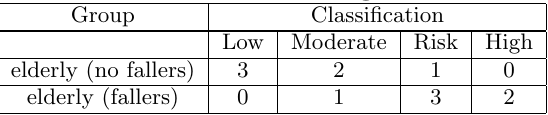
Table 2: Results of the diagnostic tool